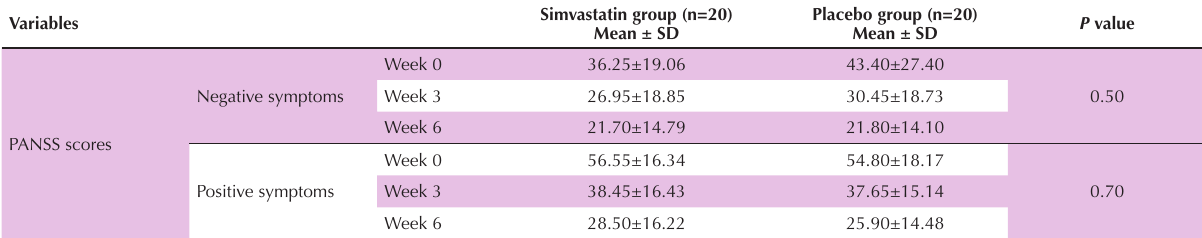
Table 2. Comparison of the mean PANNS scores in the group treated with simvastatin and placebo at weeks 0, 3 and 6 Variables